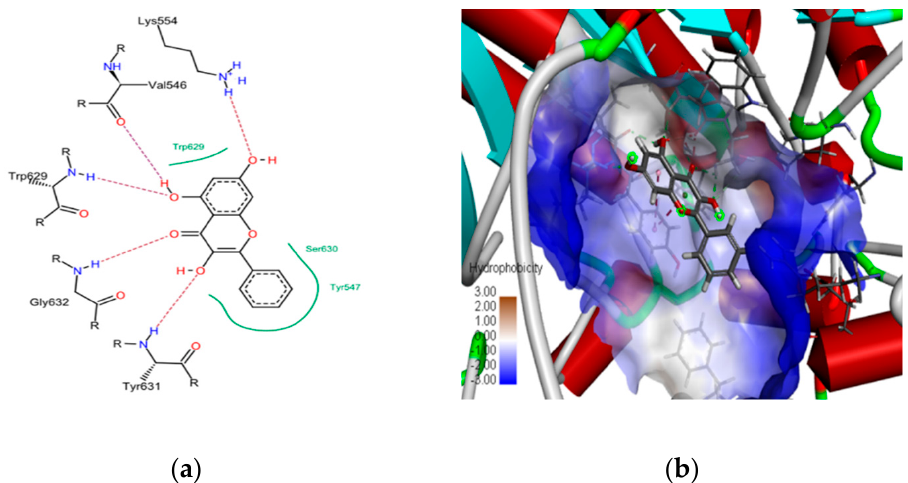
Figure 3. A two-dimensional view of galangin interacting residues with DPP-4 ( a ) and ( b ) the three- dimensional view showing the binding pose of galanin with DPP-4 enzyme, where hydrophobic surface features are visualized using discovery studio visualizer software.